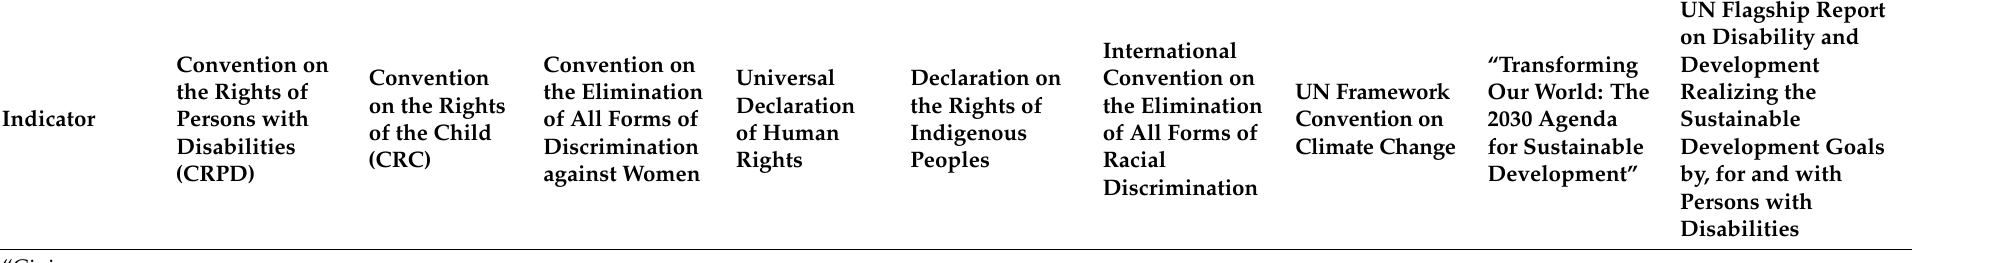
Table 7. Presence of Better Life Index indicators in the actual document such as the